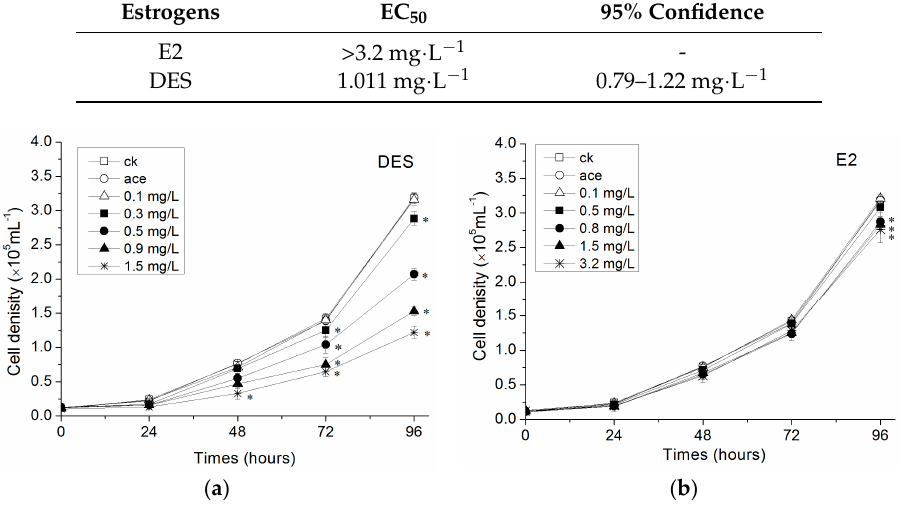
Figure 1 . Cont . Figure 1. Cont